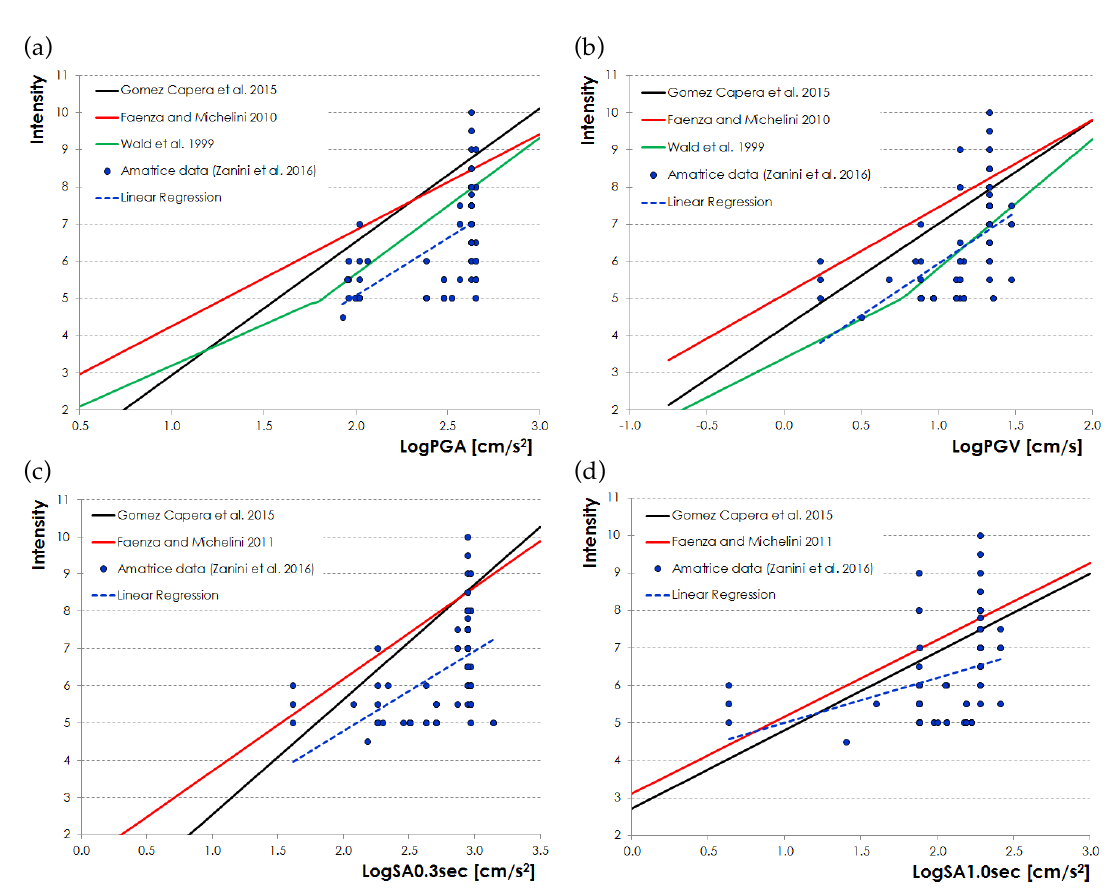
Figure 3: Comparisons between observed I for the 2016 Amatrice sequence and predicted MCS values from litera- EMS ture models based on PGA (a), PGV (b), SA(0.3) (c) and SA(1.0) (d)